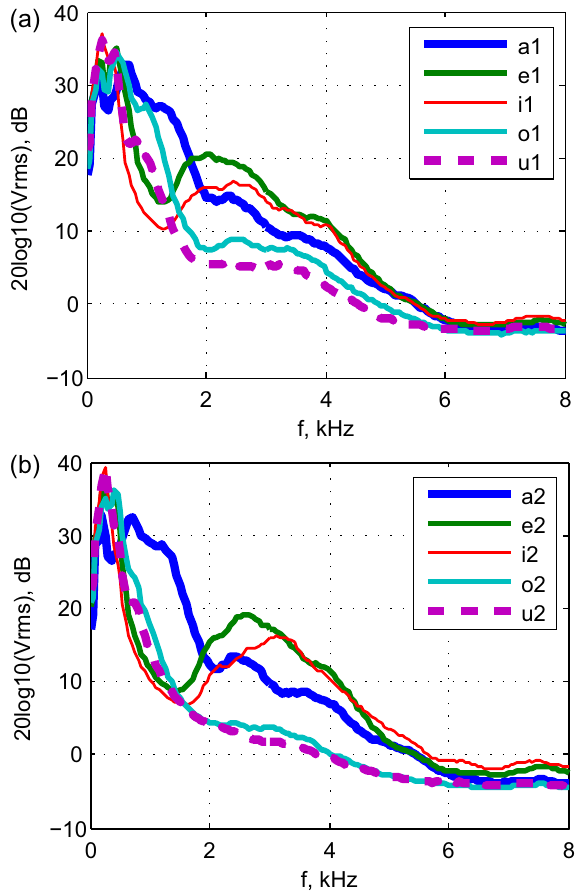
Figure 7. CVC logatomes: average RMS normalised spectra of central vowels. (a) Vowel group V1, (b) vowel group V2.